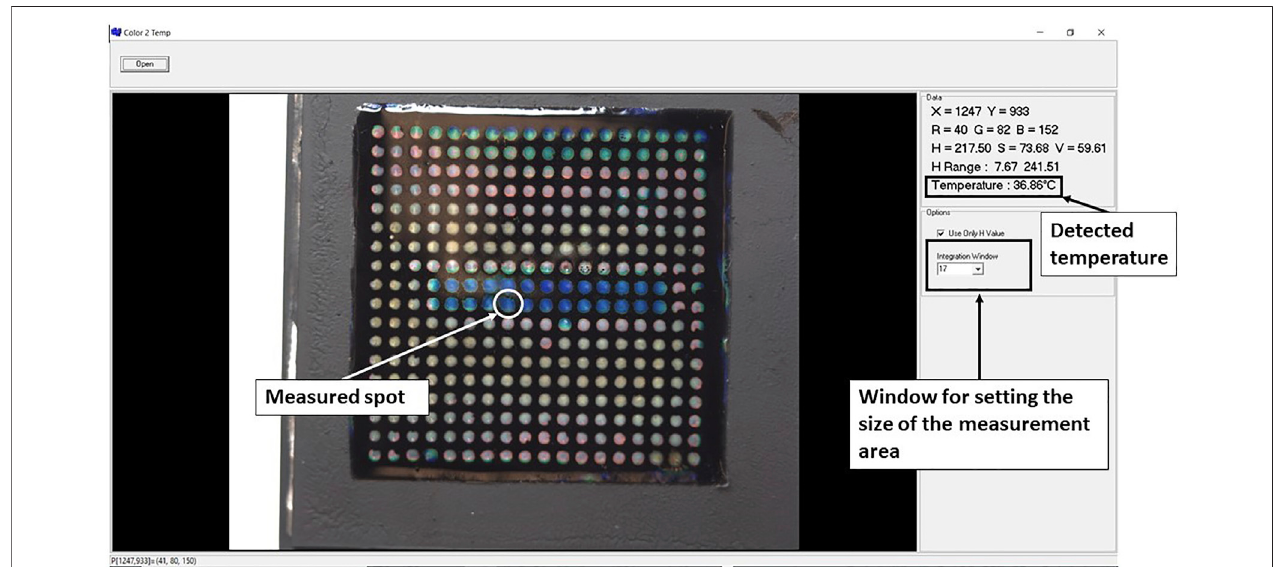
FIGURE 2 | The interface of the application used for quantitative analysis of temperature from the LC